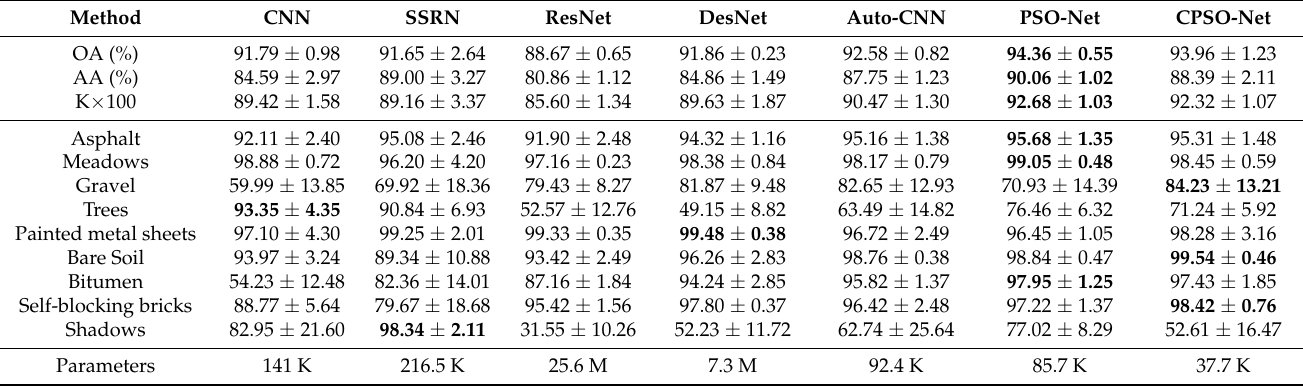
Table 3. Classification accuracy with bolding the best accuracy based on the biased Pavia dataset, run five times. Method